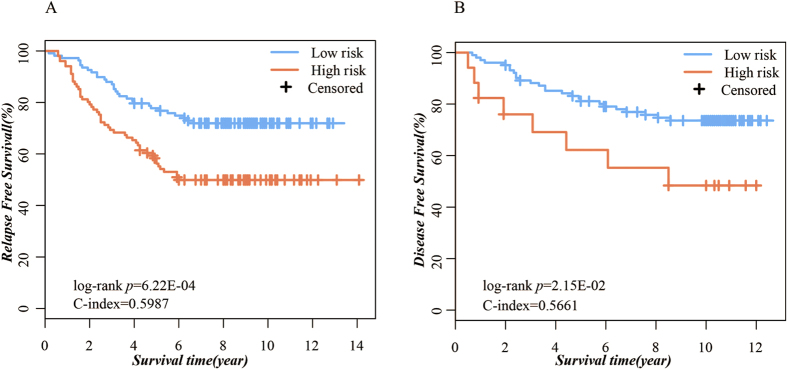
Kaplan–Meier curves illustrating relapse-free survival among patients with ER+ breast cancer based on Prognostic gene pairs in the test sets.(A) Test set 1 consisted of Sur-Data3; (B) Test set 2 consisted of Sur-Data4.